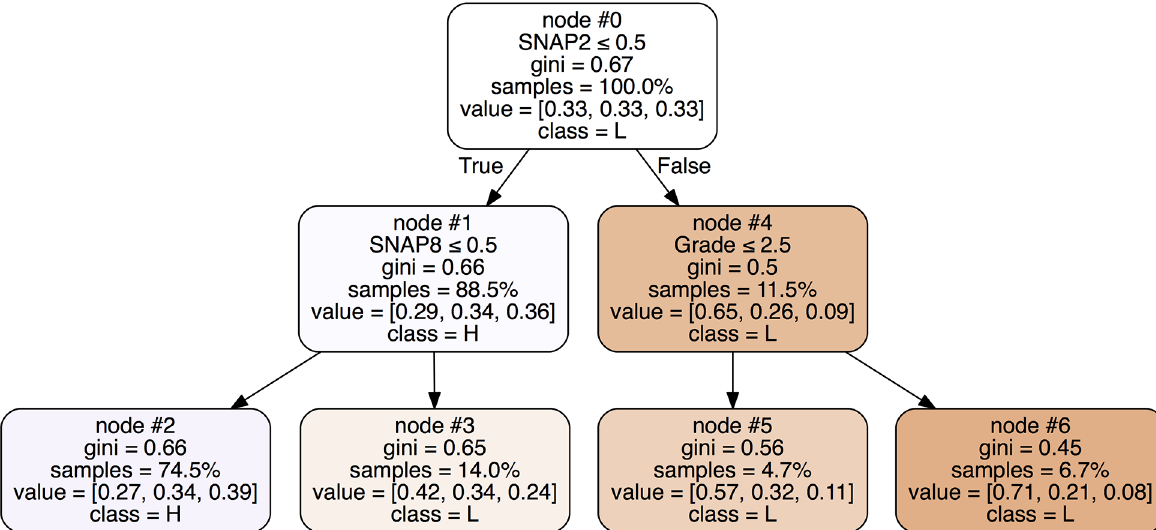
Fig 2. Fitted classification tree (CART analysis), including the predictor variables SNAP-IV items 1 to 9 (0 = “not true”; 1 = “somewhat true”; 2 = “certainly true”); gender (0 = girl ; 1 = boy ); grade (primary school class level 2, 3, 4) and the academic achievement outcome (L = low , M = medium , H = high ). The percentage in each node box denote the percentage of samples routed to that particular node—where the root node will contain100% of the samples, and a leaf node will containthe least number of samples along a rooted path in the decisiontree. The node numbersare given on top of each node box. For each split decision, True denotesthat the corresponding statement is true and then pointingto the left child node (that is either a new internaldecisionnode or a final leaf node), and False denotesthat the corresponding statement is false and then pointingto the right child node (that is either a new internal decisionnode or a final leaf node).